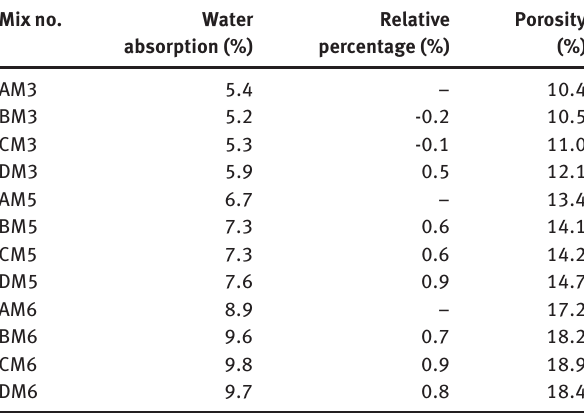
Table 3: Water absorption and porosity of AAFA mortars. Mix